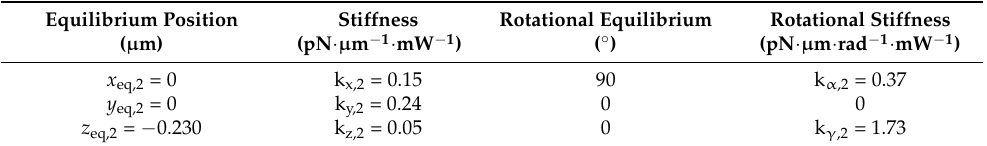
Table 1. Values of trap stiffnesses, rotational equilibrium and rotational trap stiffness for an RBC trapped by a two-beams optical tweezers. The stiffnesses are normalized over the total